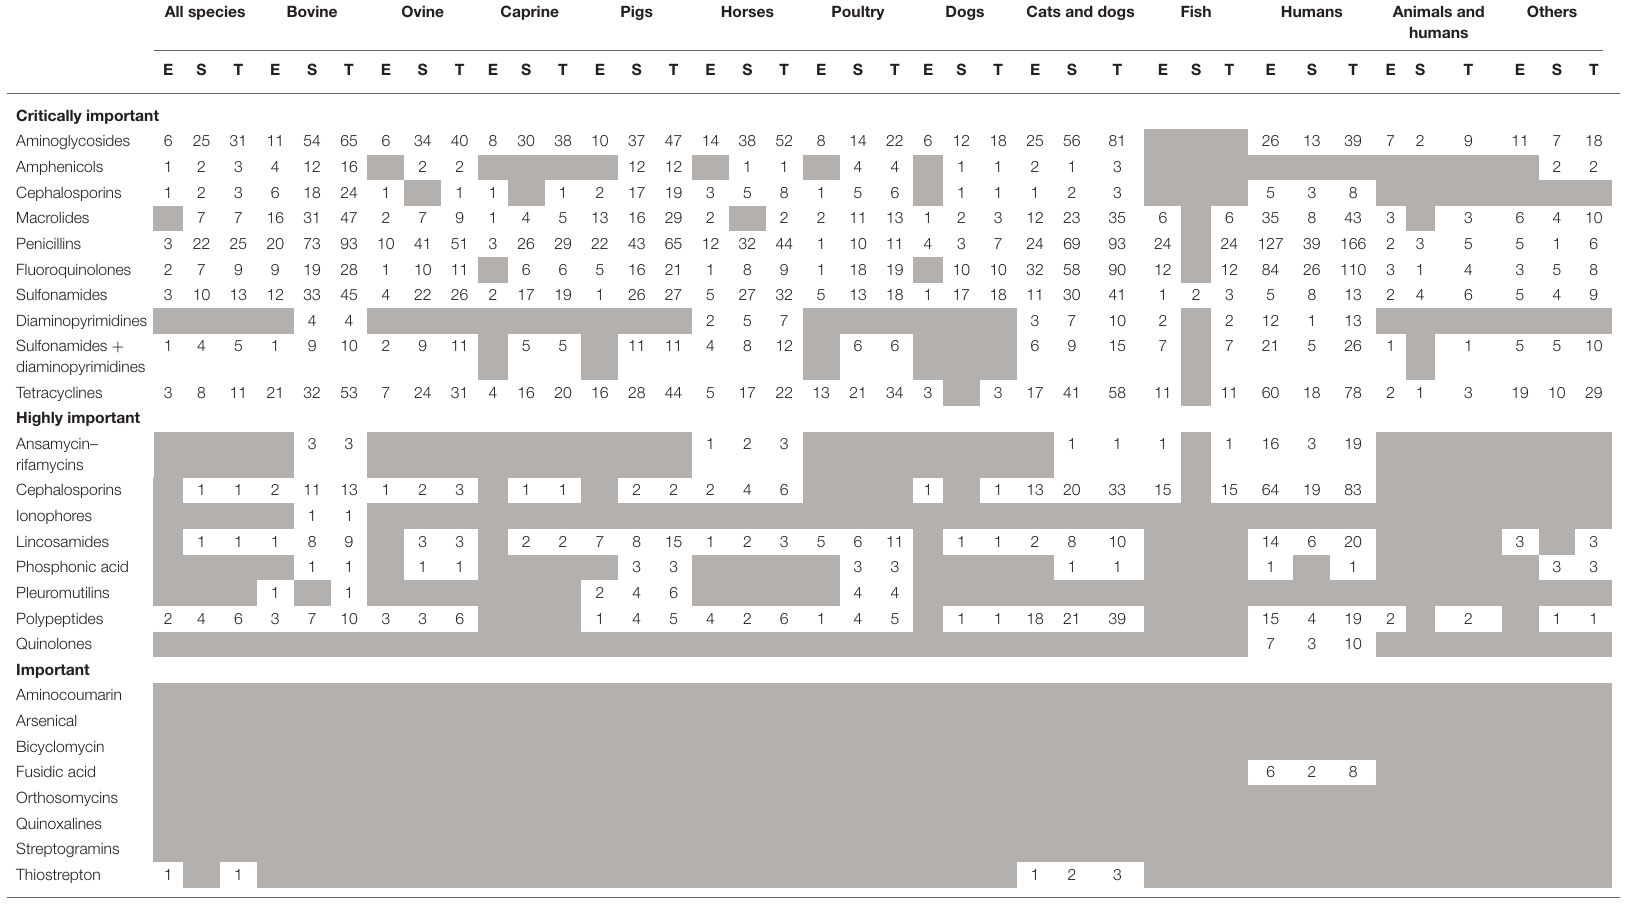
TABLE 7 | Distribution of the antibiotic offers, according to the species they are intended to and classified following the OIE list of antimicrobial agents of veterinary importance (22), in the searches in English and in Spanish. All species Bovine Ovine Caprine Pigs Horses Poultry Dogs Cats and dogs Fish Humans Animals and